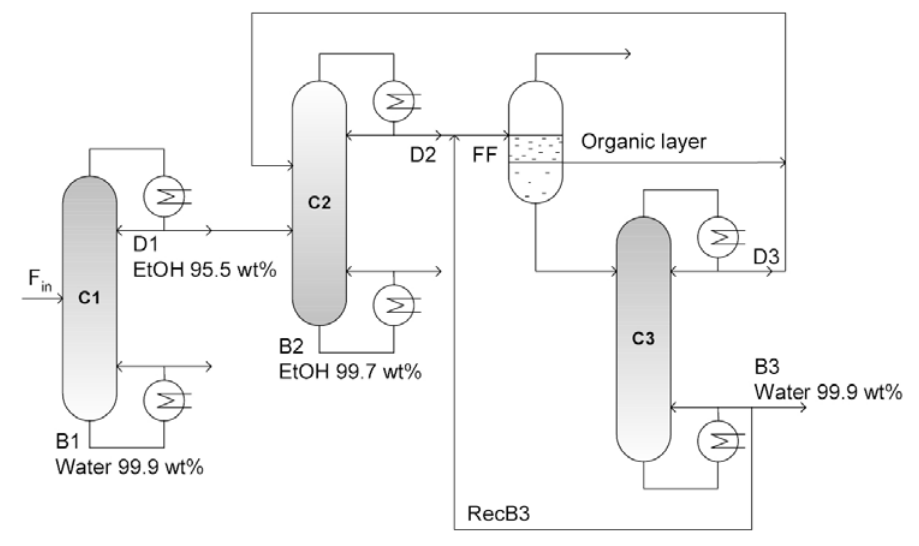
Fig. 9 Azeotropic distillation with cyclohexane as entrainer.